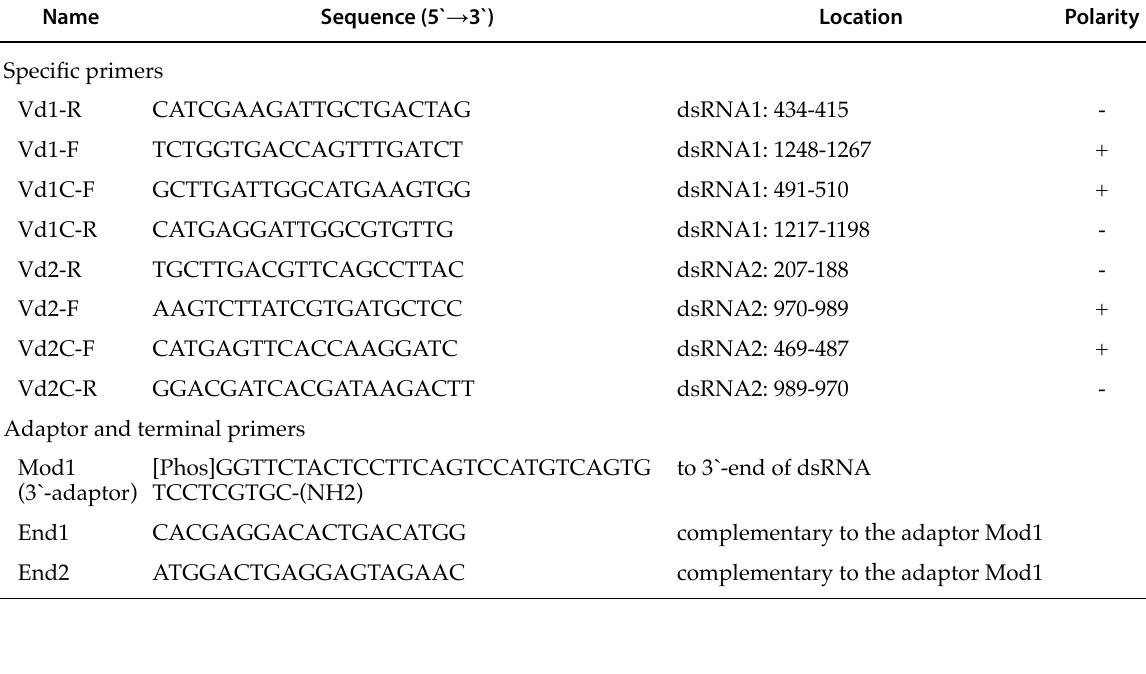
Supplementary Table 1. Primers designed in this study for the molecular characterization of VdPV1-ol